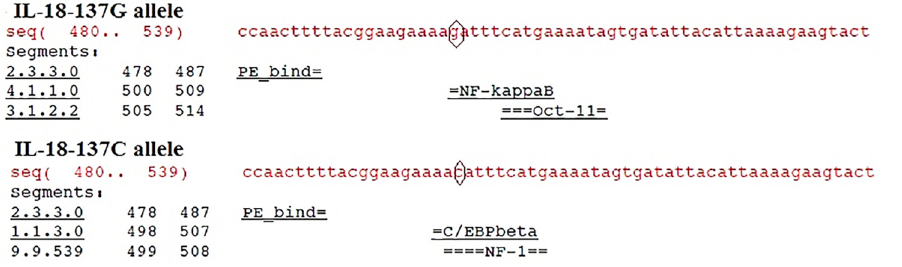
Fig 3. Analysis of Promoter binding site for IL -18-137 G/C